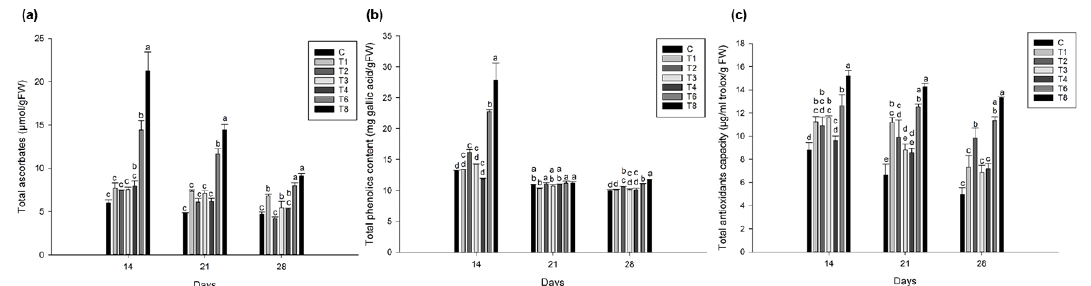
Figure 8. Effect of the preharvest treatment of ANE, HA, and different combinations of ANE + HA on ( a ) total ascorbates content, ( b ) total phenolics content, and ( c ) total antioxidant capacity of leaves of spinach stored at 0–4 °C in the dark with RH ≥ 95% for 14, 21, and 28 days after harvest. Different combinations of ANE and HA used for preharvest treatment were as follows: C (control), T1 (0.1% ANE), T2 (0.25% ANE), T3 (0.2% HA), T4 (0.4% HA), T6 (0.1% ANE + 0.4% HA), and T8 (0.25% ANE + 0.2% HA). Each experiment was performed in triplicate, and each experimental unit had six plants. The average of the eighteen values were presented as mean ± SE and means represented by same letters were not significantly different at p ≤ 0.05.